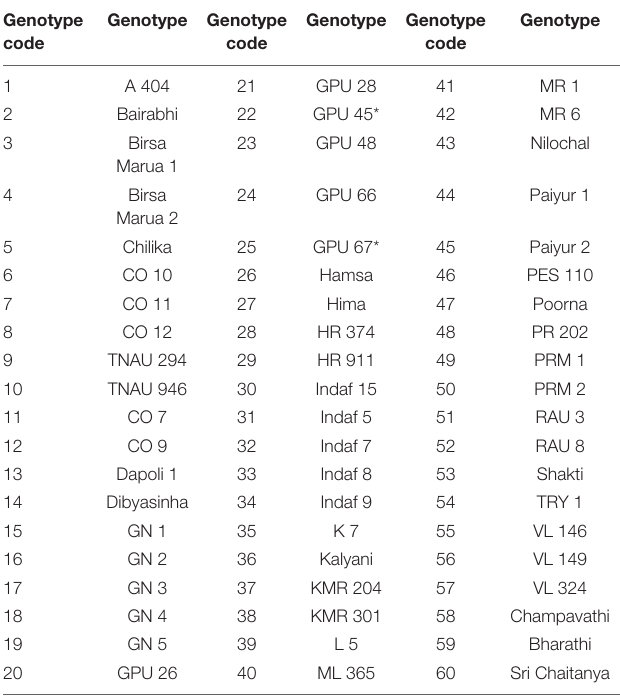
TABLE 1 | List of finger millet genotypes evaluated under six test environments during the main seasons of 2011–2016. Genotype